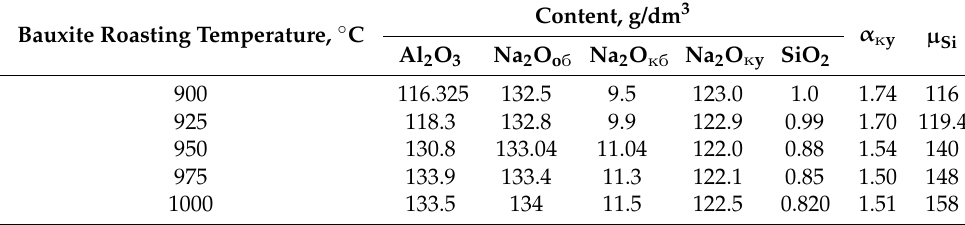
Table 2. The compositions of aluminate solutions (with α к y and µ Si